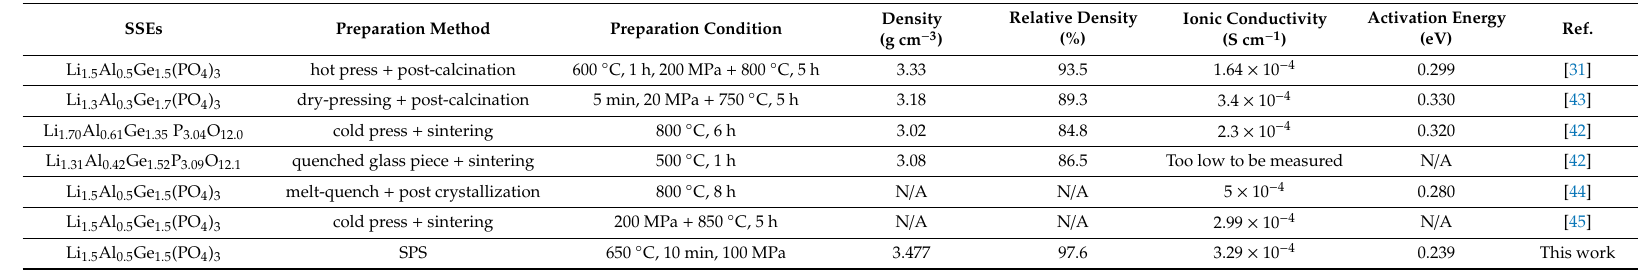
Table 2. Summary of the density, relatively density, ionic conductivity, and activation energy for LAGP pellets fabricated using di ff erent methods.